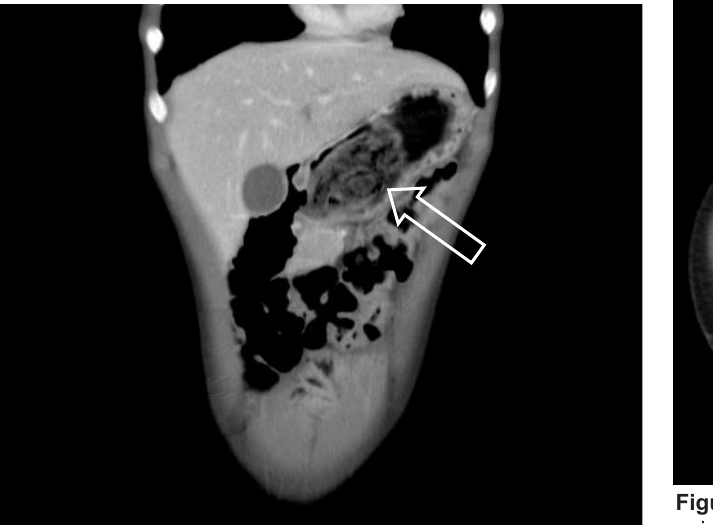
Figure 1. Bezoar in the stomach.